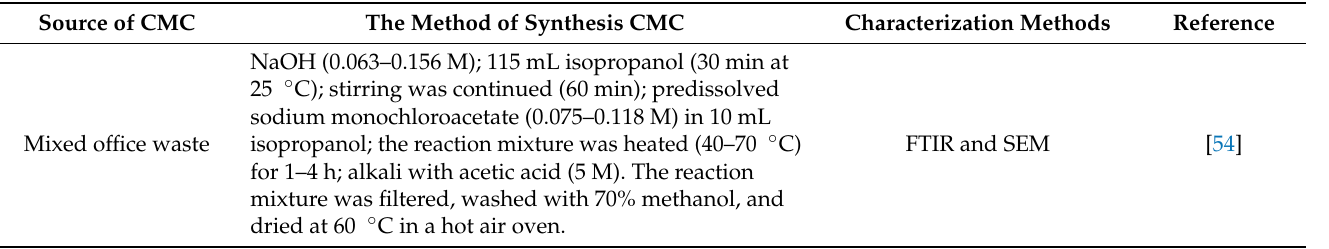
Table 3. Synthesis of